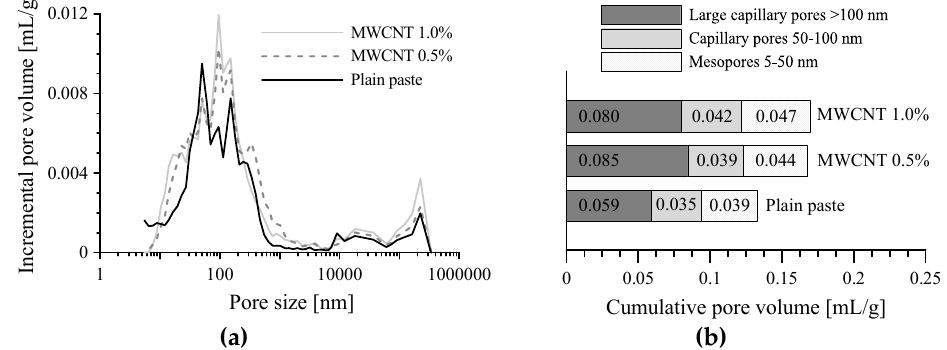
Figure 10. Porosity of cement-based composites with 0.5 and 1.0 vol.% MWCNTs; ( a ) incremental pore